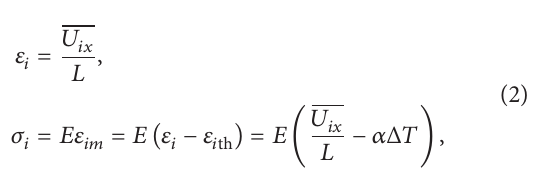
Table 1: Constant parameters